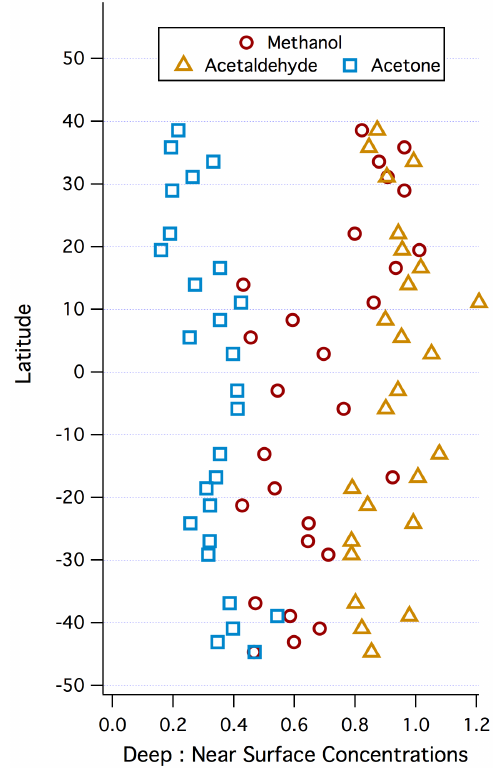
Figure 7. Ratios of seawater OVOC concentrations from depth (nominally 500m) to those from ∼ 5m. For methanol, this ratio was ∼ 0.8 in the North Atlantic and ∼ 0.6 elsewhere. For acetaldehyde, concentrations at depth were similar to concentrations near the sur- face. Acetone concentration showed the most reduction at depth, with a fraction ranging from ∼ 0.2 in the subtropical North Atlantic to ∼ 0.4 in the higher latitudes of the South